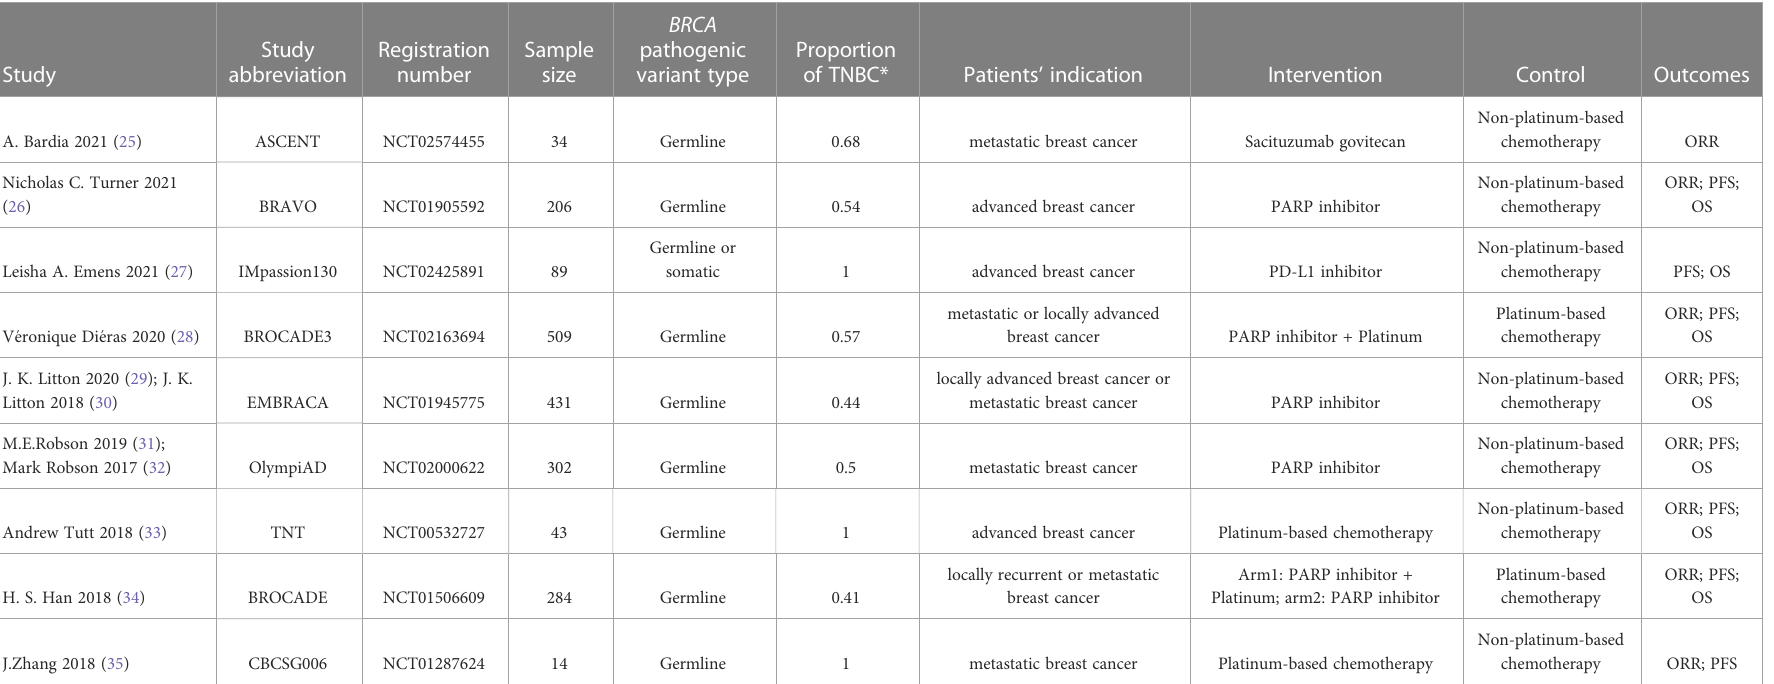
TABLE 1 Characteristics of the included